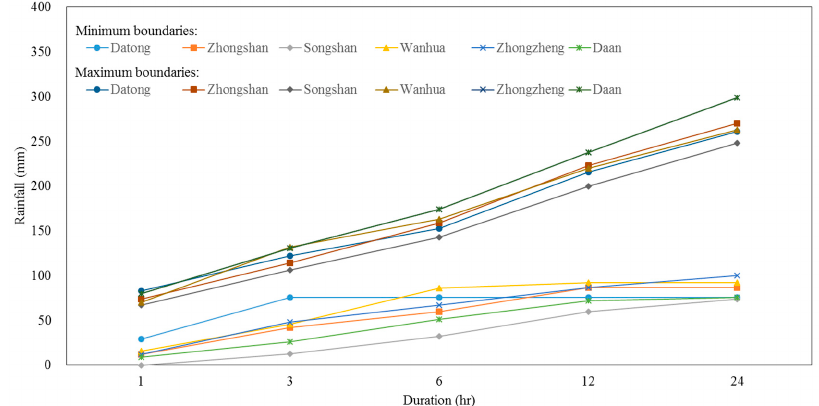
Figure 8. The minimum boundaries and maximum boundaries for rainfall thresholds.